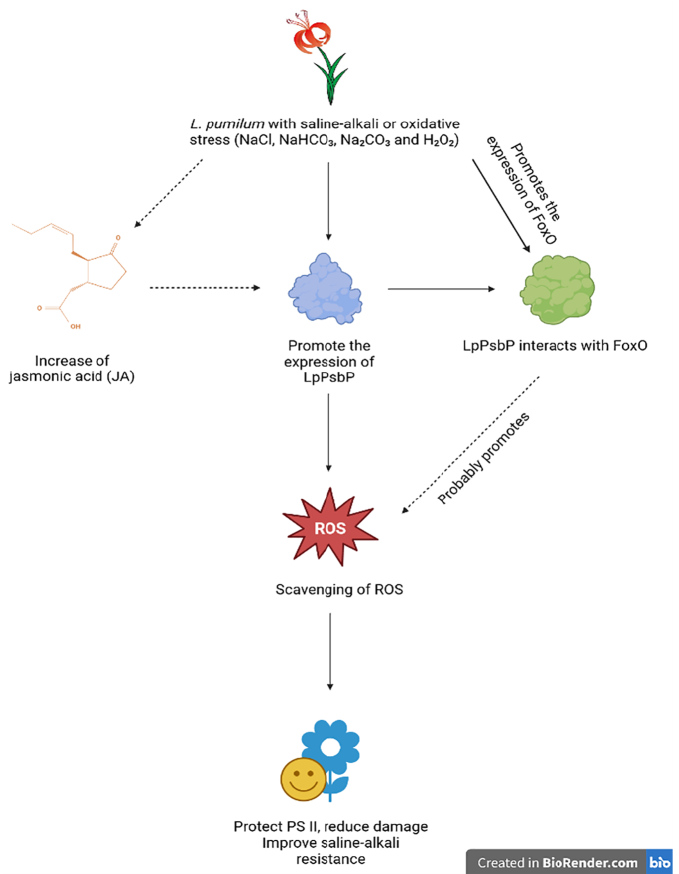
Figure 8. Concluded mechanism of how LpPsbP improves saline – alkali resistance in L. pumilum . After Saline-Alkaline stress and oxidative stress (caused by NaCl, NaHCO 3 , Na 2 CO 3 and H 2 O 2 ), L. pumilum creates ROS at a variety of locations, including chloroplasts. The sub-site of ROS generation in chloroplasts is mostly at the center of the oxygen-releasing complex. When encountering these stresses, the expression of LpPsbP is promoted. Then, LpPsbP will scavenge ROS, which means it will finally safeguard the PS II of L. pumilum , lessen damage to it, and therefore increase the ability of plants to tolerate stress. Moreover, we have made two additional speculations: 1. Following stress, L. pumilum generates more JA, which directly promotes the expression of the PsbP gene. 2. First comes with the fact that the FoxO gene will express itself more when ROS are created, which means that L. pumilum encounters these two kinds of stress. Then, because these two ROS scavenging proteins (LpPsbP and FoxO) can interact with each other, it will promote the scavenging of ROS, leading to a better protection and resistance. This figure is made using BioRender website (https://biorender. com/), dashed lines in this figure means these are speculations instead of definitive